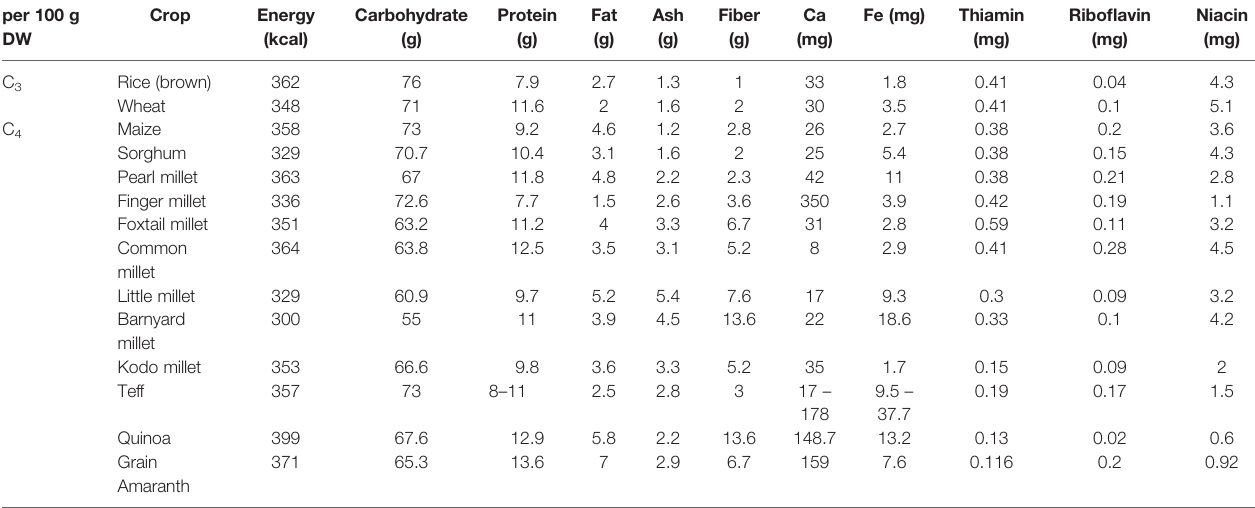
TABLE 1 | Comparison of nutritional composition of grains of several cereal and orphan crops.